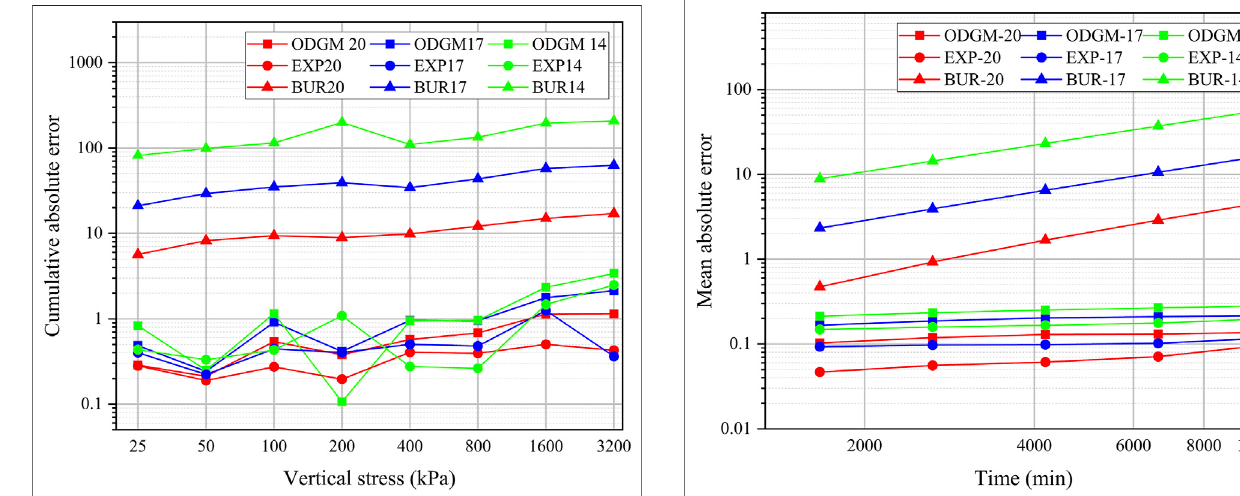
FIGURE13| Relationshipofmeanabsoluteerrorandverticalstress(log- scale) of three models in the process of prediction (20 data points/17 data points/14 data points).